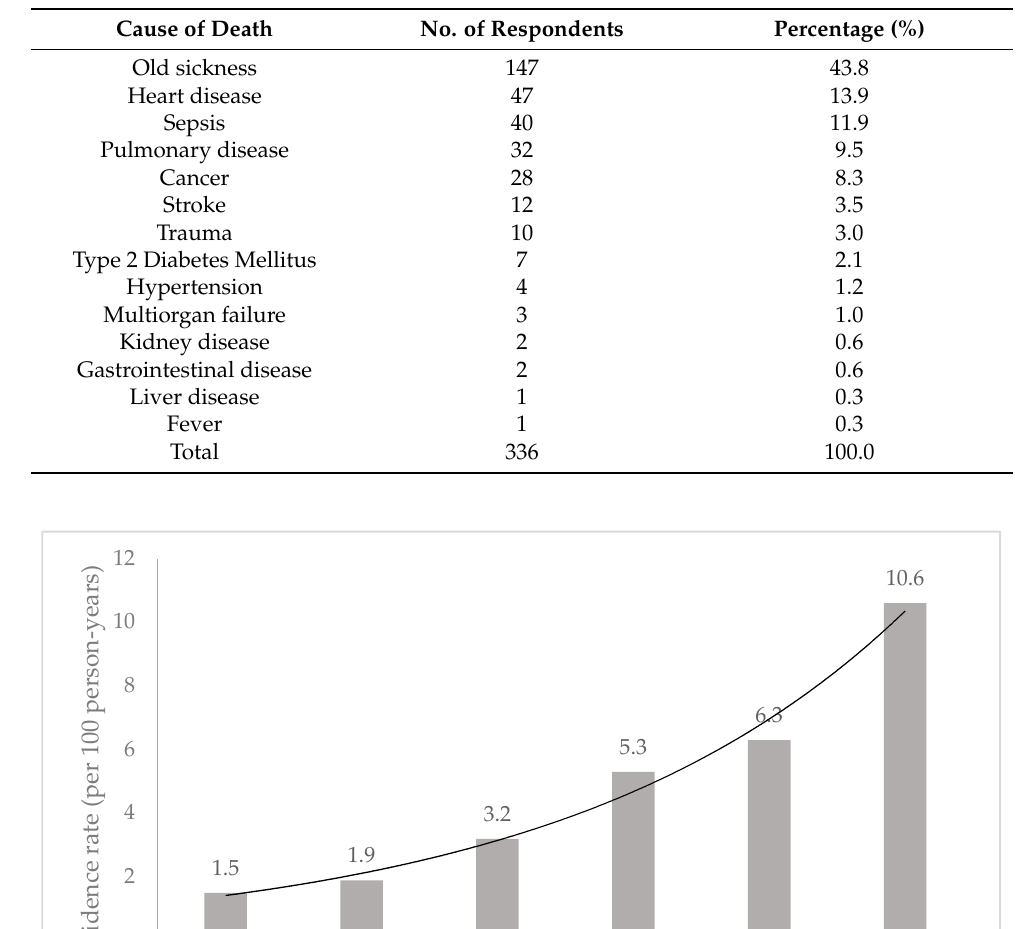
Table 1. The cause of death.